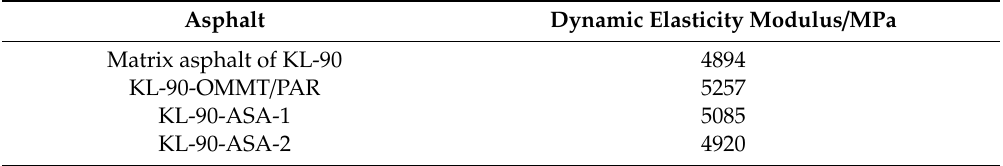
Table 14. Dynamic elasticity modulus of asphalt mixtures with anti-stripping composites.